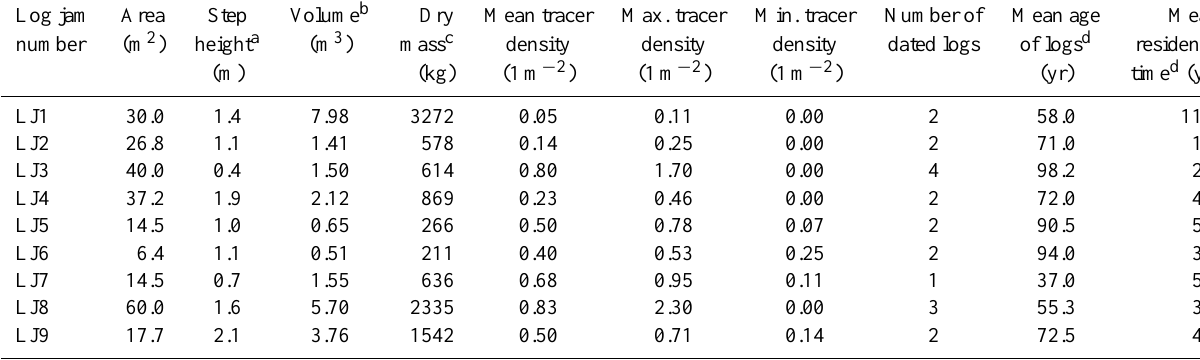
Table 3. Log jam (LJ) characteristics and tracer log point densities for the log jam perimeters in the